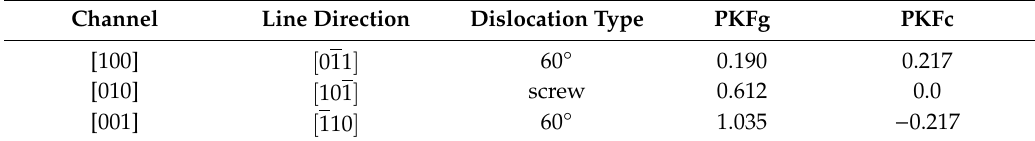
Table 6. Normalized Peach Köhler glide (PKFg) and climb forces (PKFc) for dislocation family 1 (blue dislocation in Figure 9, Burgers vector: 1 / 2 [ 101 ] ) in the three types of γ -channels.